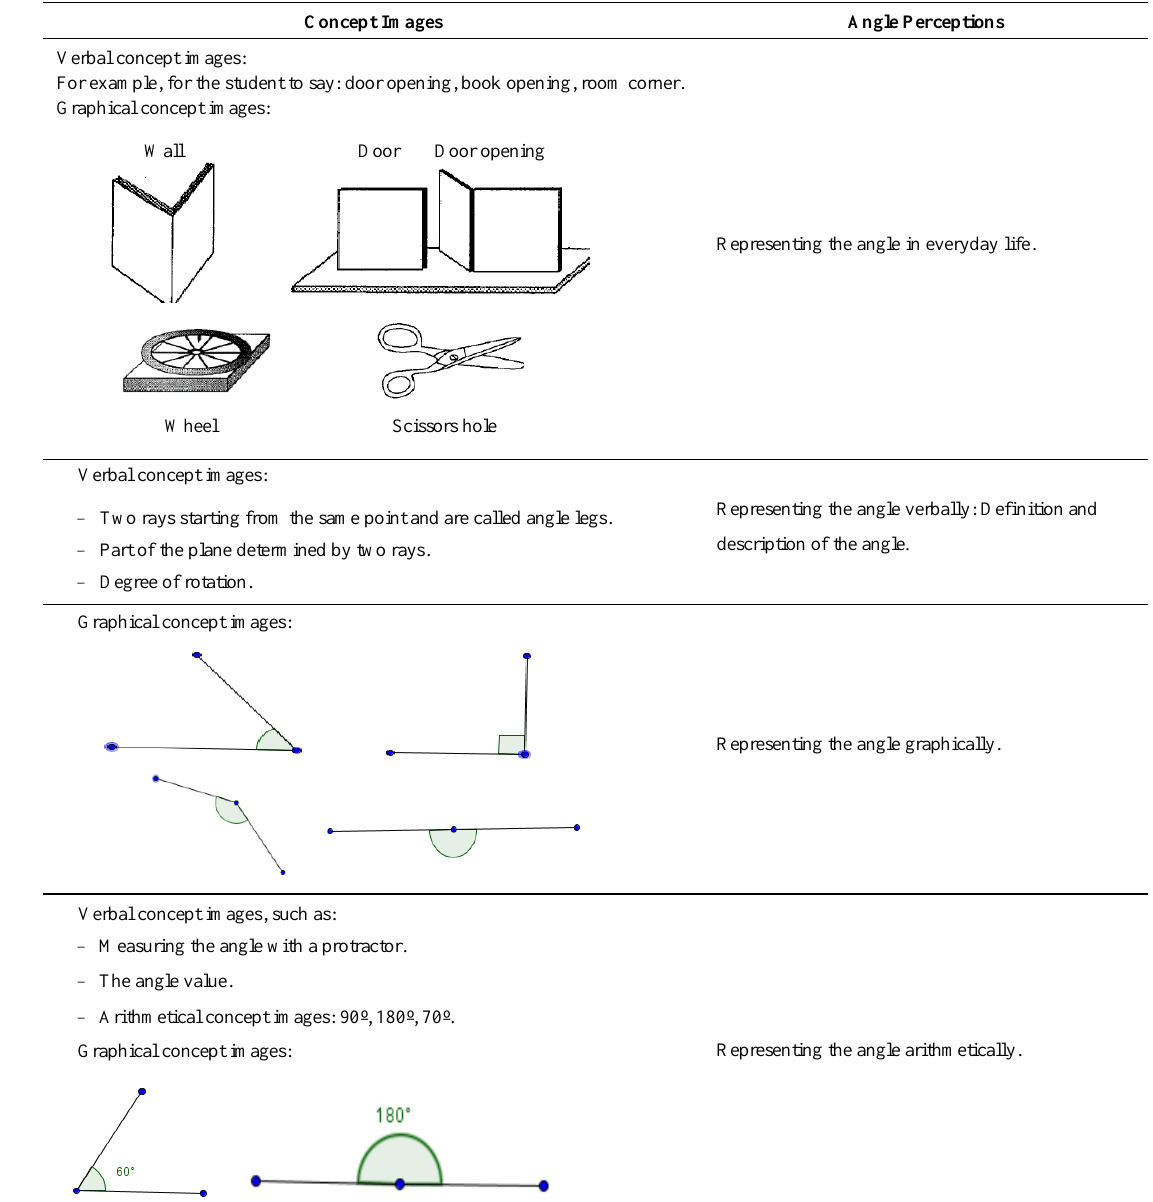
Table 1. Examples of concept images of various angle perceptions